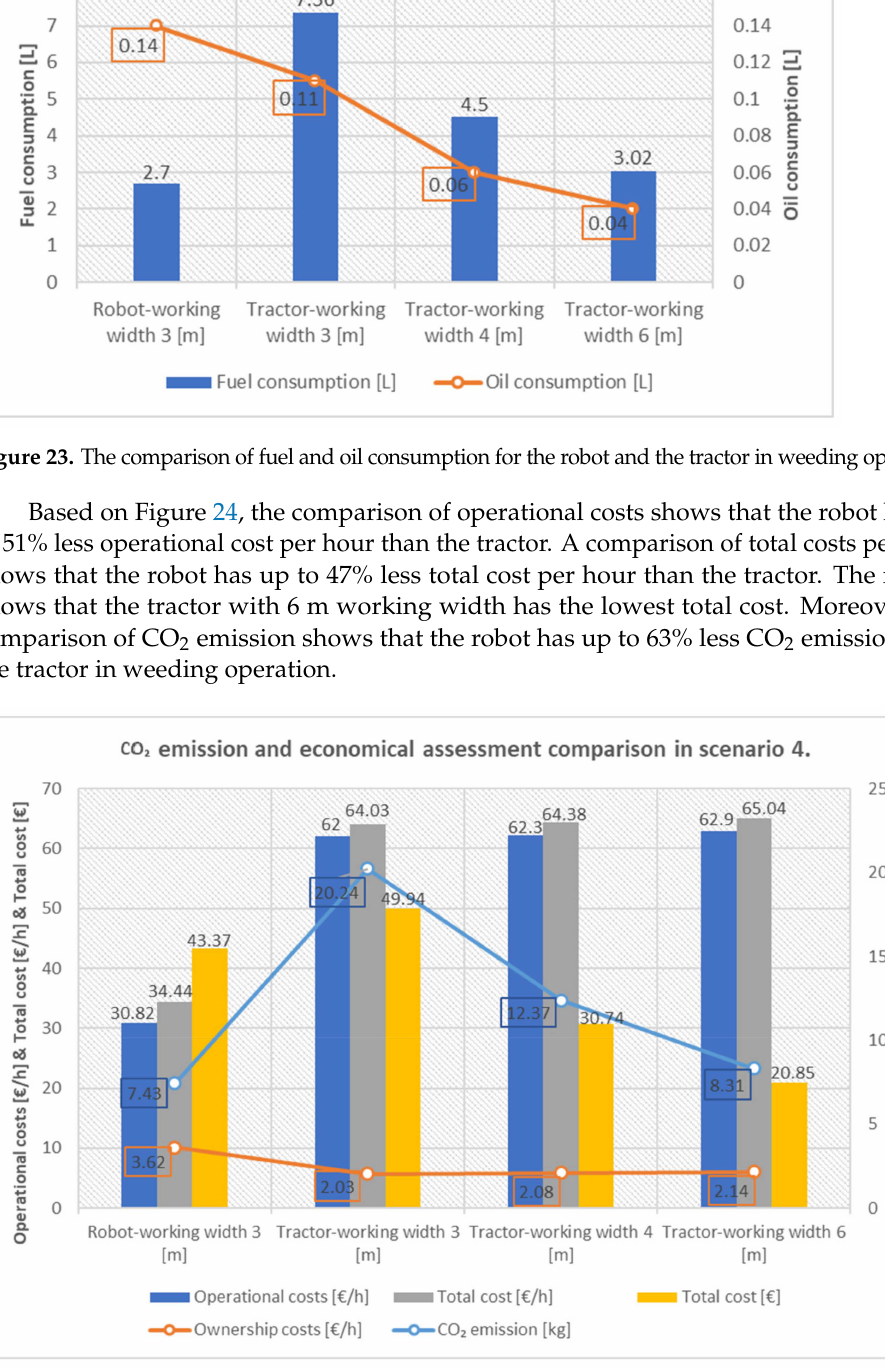
Figure 24. The comparison of economical assessment and CO 2 emission between robot and